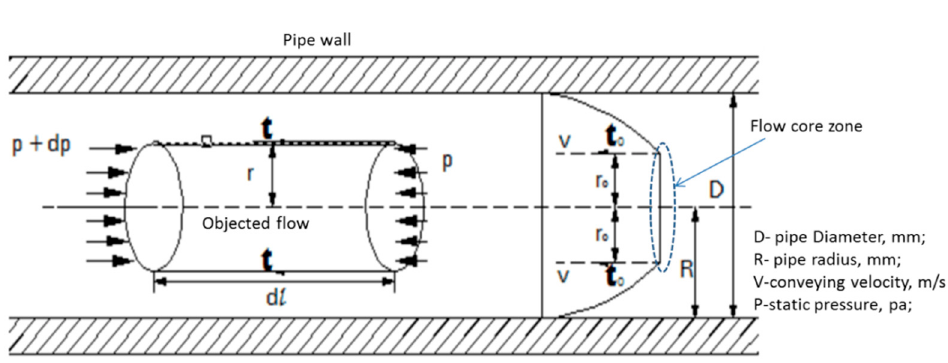
Figure 9. The overview of the static analysis for the CGFB slurry.